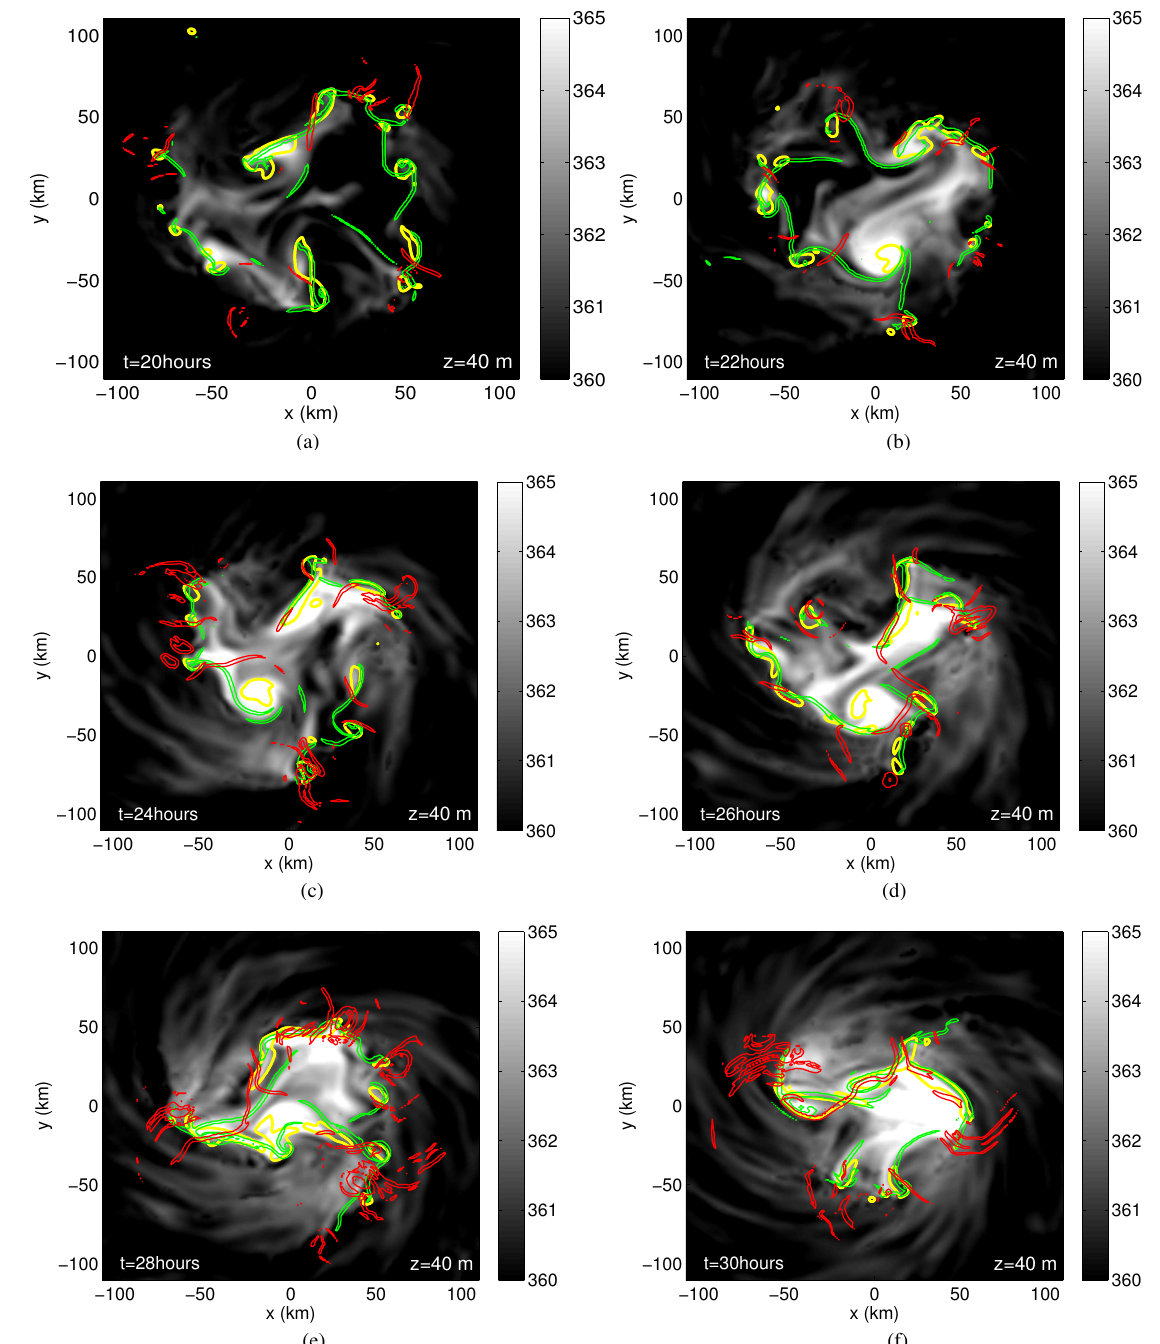
Fig. 12. Planar attracting (green) and repelling (red) FTLE ridges and vorticity contours (yellow) are overlaid on θ e fields with 1 hour integration time at times from 20 hours to 30 hours every 2 hours at the bottom of the boundary layer.